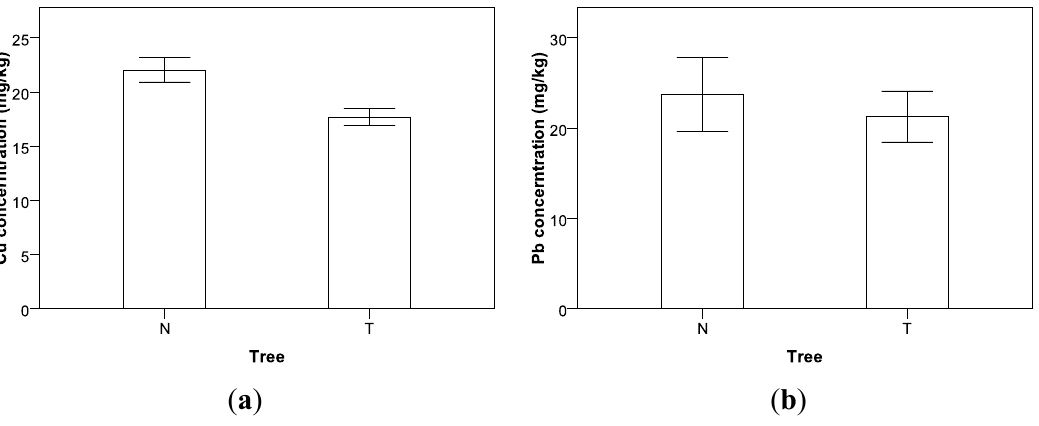
Figure 6. Interaction between altitude and